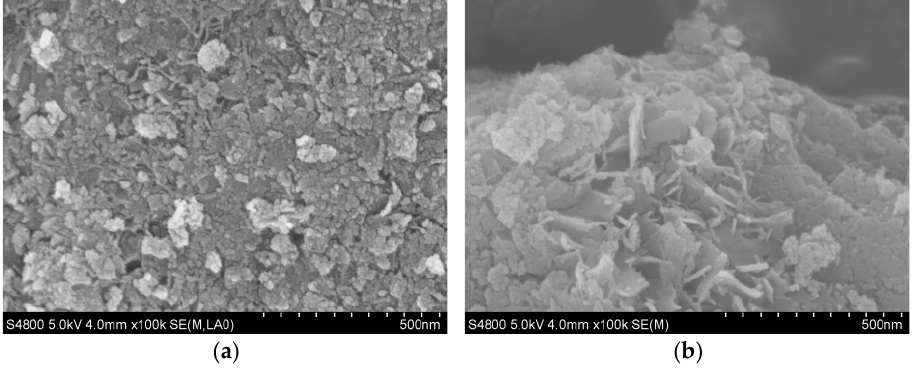
Figure 1. SEM image of fresh alumina ( a ), MAA ( b ). BET tests were also conducted to manifest the pore parameters of the adsorbent. The possessed pore diameter and surface area of nascent AA were approximately 0. 434 nm and 287.259 m 2 /g, respectively (Table S1). After the impregnation process, the pore size was slightly diminished to 0.377 nm with certain manganese oxides clogged, while the average surface area was elevated to 295.599 m 2 /g. The enlarged specific surface area facilitated the exposure of adsorption sites and benefited from fluoride removal. As described in Figure 2, the plots of N 2 adsorption ‐ desorption isotherm with parallel trends were discussed. According to the standard of IUPAC, the nature of the isotherm curve for both the samples were belong to type IV with an H3 hysteresis loop. Implied that the